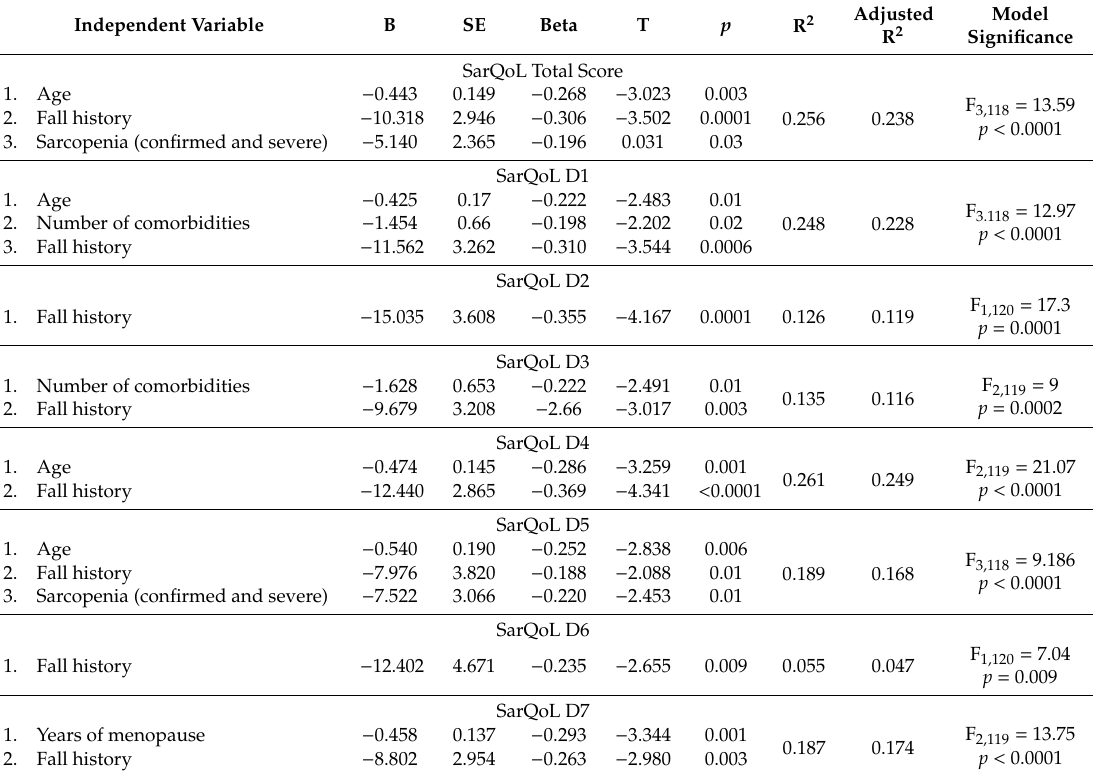
Table 4. Multiple Linear Regression Analysis with the Total and the Seven Domain Scores of SarQoL as Dependent